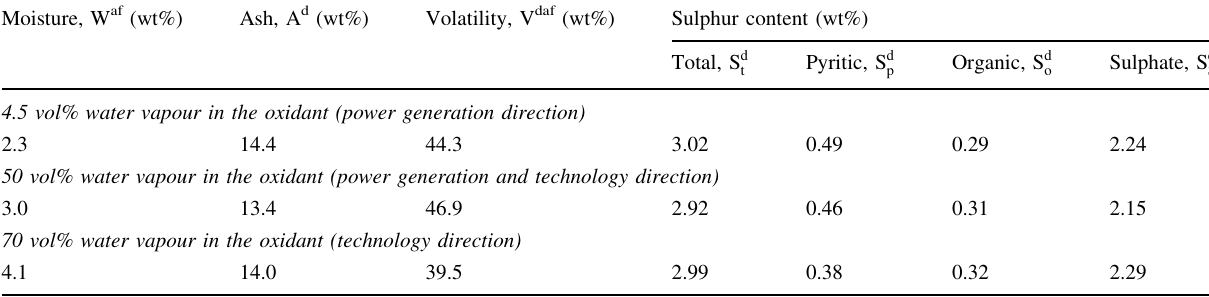
Table 7 Characteristic of desulphurized